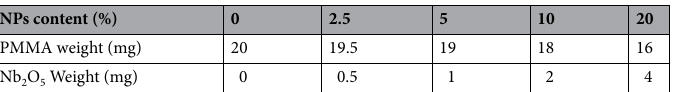
Table 1. Weight and concentration of individual chloroform/polymer/NPs